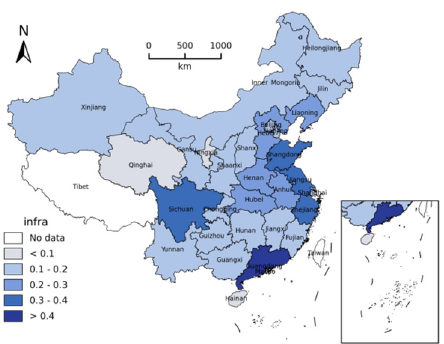
Figure 3. Distribution of new digital infrastructure (2008–2019).